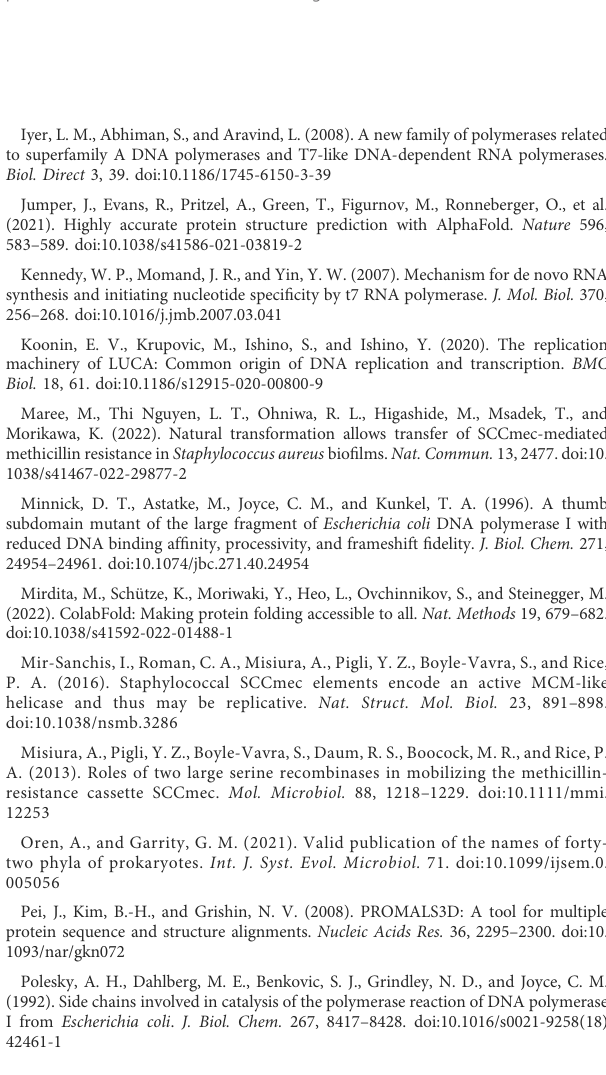
SUPPLEMENTARY FIGURE S1 Pairwisesequenceidentitiesamongproteinsstudied,ascalculatedbyClustal Omega. SUPPLEMENTARY FIGURE S2 Predicted Alignment Error plots for all predicted complex structures. In all cases, protein A is the putative polymerase and B is the putative SSB. Plots are shown for all 5 models predicted for each complex. The last page provides a guide to interpreting these plots. SUPPLEMENTARY FIGURE S3 Genomic context of Pol-SSB pairs. Diagrams of the region encoding each pairareshown,coloredtohighlightrelevantfeatures(iffound).Red,PolA(or minimal Pol-like protein); pink, SSB; purple, helicase; bright blue, large serine recombinase; yellow, putative insertion sites, pale blue, other recombinase possibly involved in mobility; dark blue, homology to genes found in the recombinase locus of SCC elements. For extremely long elements, dotted lines simply connect one segment to the next (they do not signify gaps). See Table 1 for accession numbers. SUPPLEMENTARY FIGURE S4 Alignment of all “ large ” Pol proteins with the 1qsl.pdb – a structure of the Klenow fragment of E. coli DNA Pol I, which lacks the 5 ′ -3 ′ exonuclase but includes the 3 ′ -5 ′ exonuclease and the polymerase domains. Promals3D was used to create this alignment. Active site residues are marked with asterisks over the sequences (blue for the 3 ′ -5 ′ exonuclease and red for the polymerase sites), and Helix O of the E. coli Pol I, which makes important interactions with substrates, is also labeled. The helix that is shorter in the predicted structures, relevant to binding of the 1st dNTP, is marked with